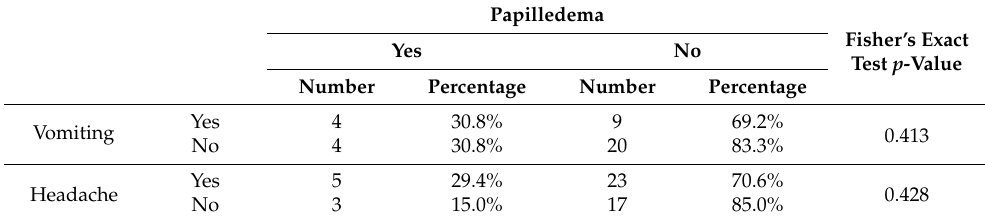
Table 4. Comparison of the presence of papilledema according to the symptoms.